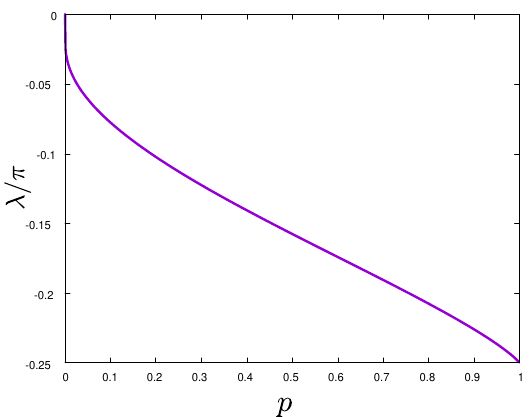
Figure 2. The Stokes correction phase as a function of the non-adiabatic probability p